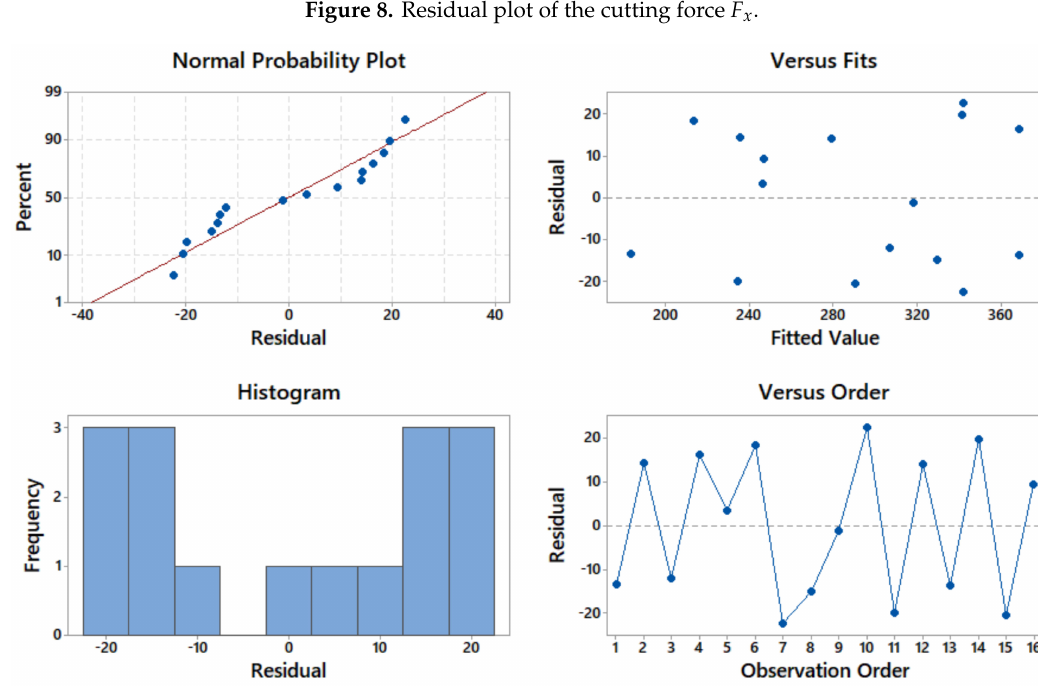
Figure 9. Residual plot of the cutting force F y